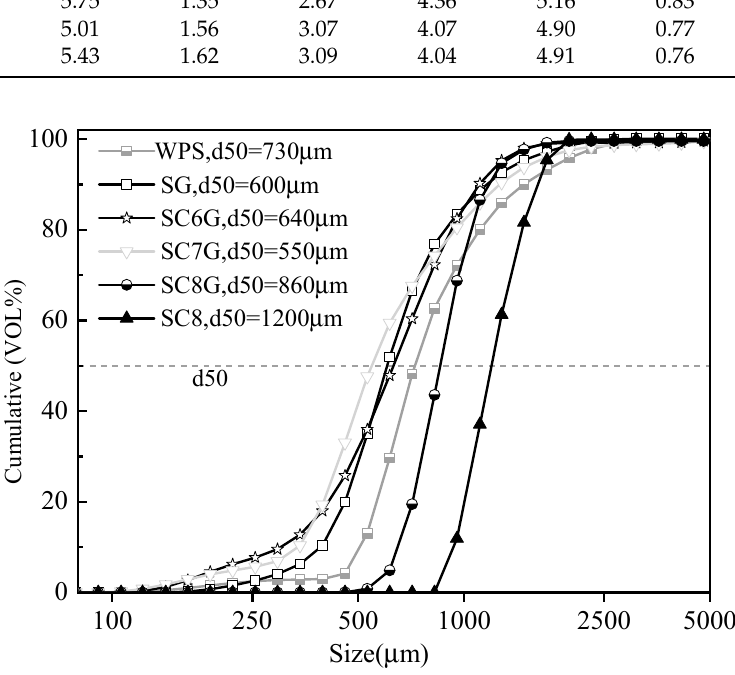
Figure 1. Cumulative particle size distribution curves of the untreated, mechanochemically, and thermally activated WPS.